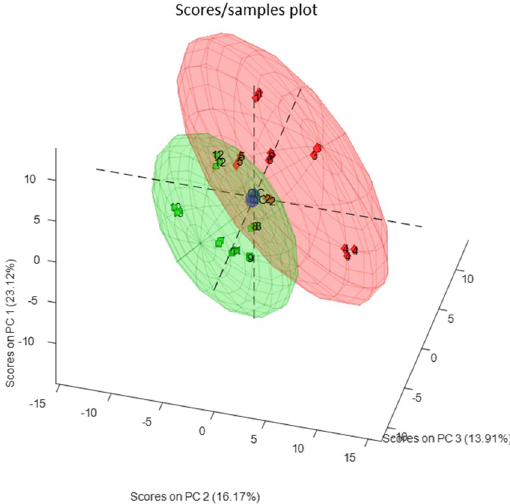
Figure 5. Score plot from PCA model calculated on the relative concentrations of the variables in the reduced dataset. Green: control samples. Red: CF samples. The blue samples in the centre are the QC samples. Data has been auto